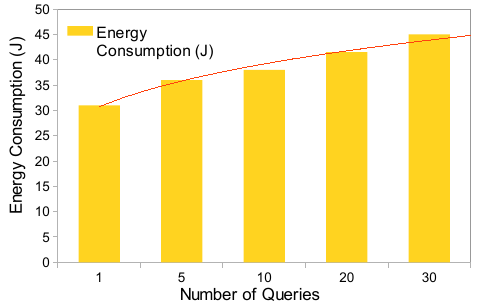
Figure 20. Energy Consumption - MOSDEN Client (Sensing + Sending)